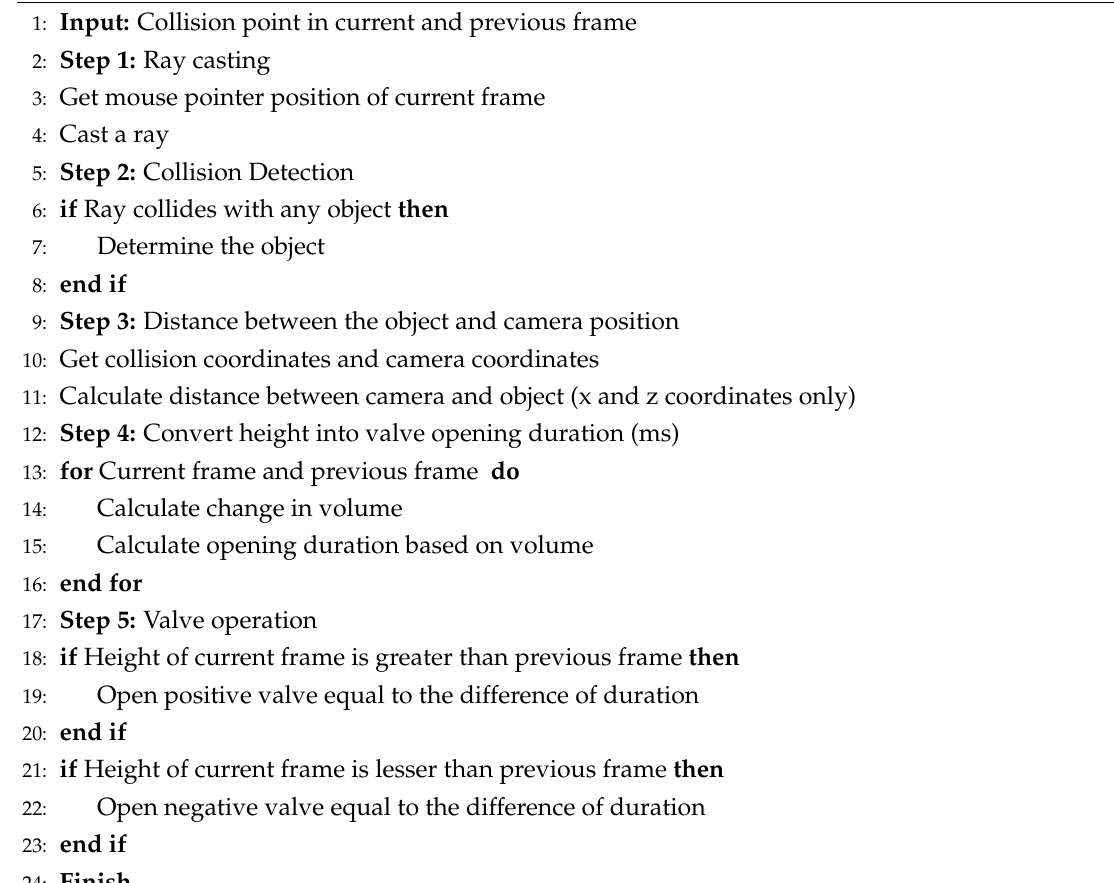
Algorithm 1 Geometry